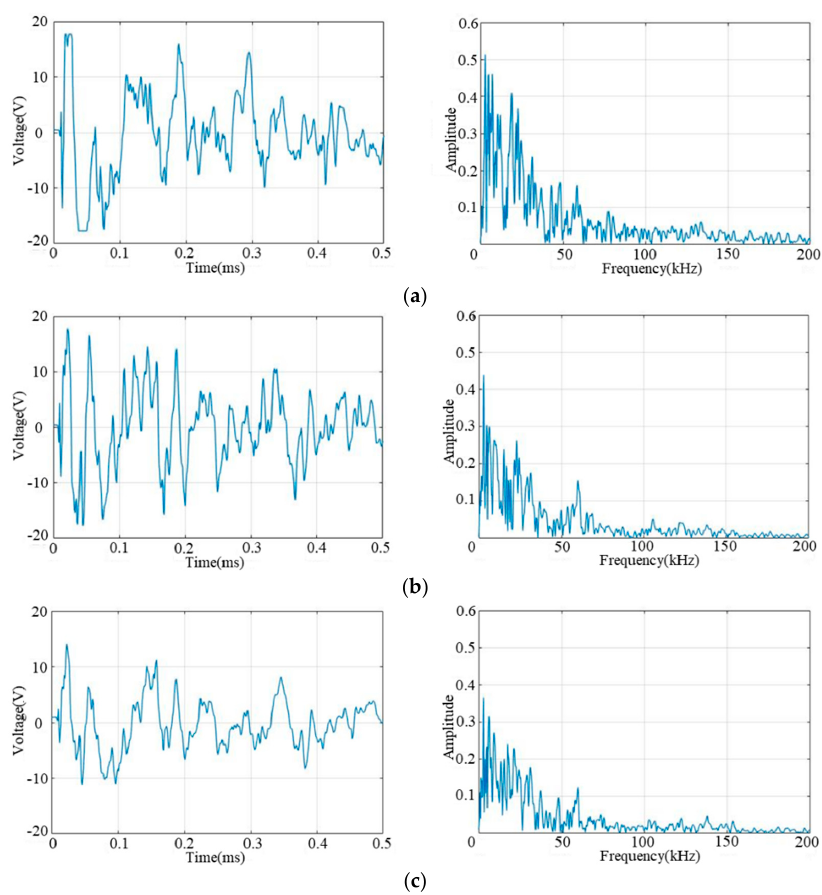
Figure 7. Typical impact response signals and frequency spectrums of different sensor connection types: ( a ) The impact response signal and frequency spectrum of PZT 3 in independent connection type; ( b ) The impact response signal and frequency spectrum of A1 in series connection type; ( c ) The impact response signal and frequency spectrum of A1 in parallel connection